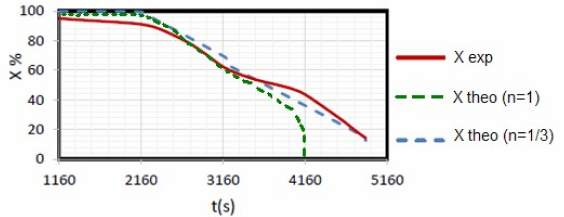
Figure 5. Model validation for 5 ◦ C/min heating rate with n = 1/3 and n = 1 kinetic